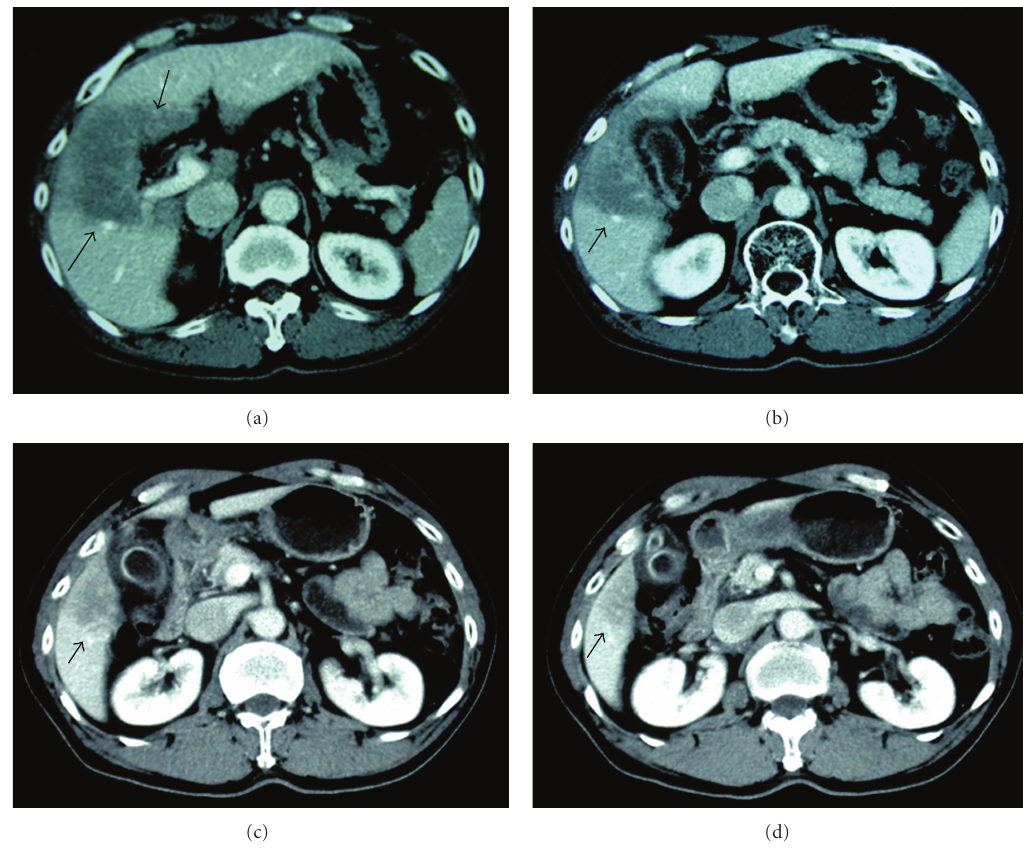
Figure 3: Postradiation CT scans corresponding to the sections in Figure 1. The region of low attenuation in the liver (arrows) corresponded to the treatment volume at 2 months after completion of 3D CRT. The tumor appears to have a complete response to 3D CRT.